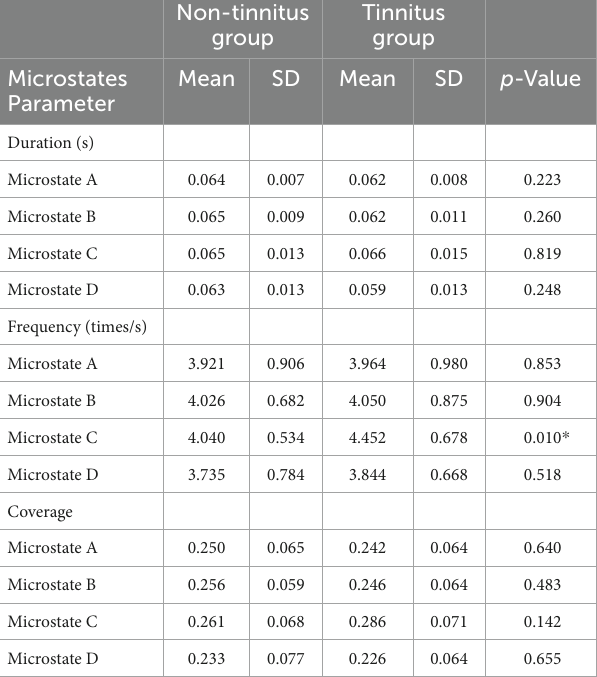
TABLE 2 Parameters of the non-tinnitus group and the tinnitus group. TABLE 3 Correlation analysis of THI scores with microstates duration, frequency, and